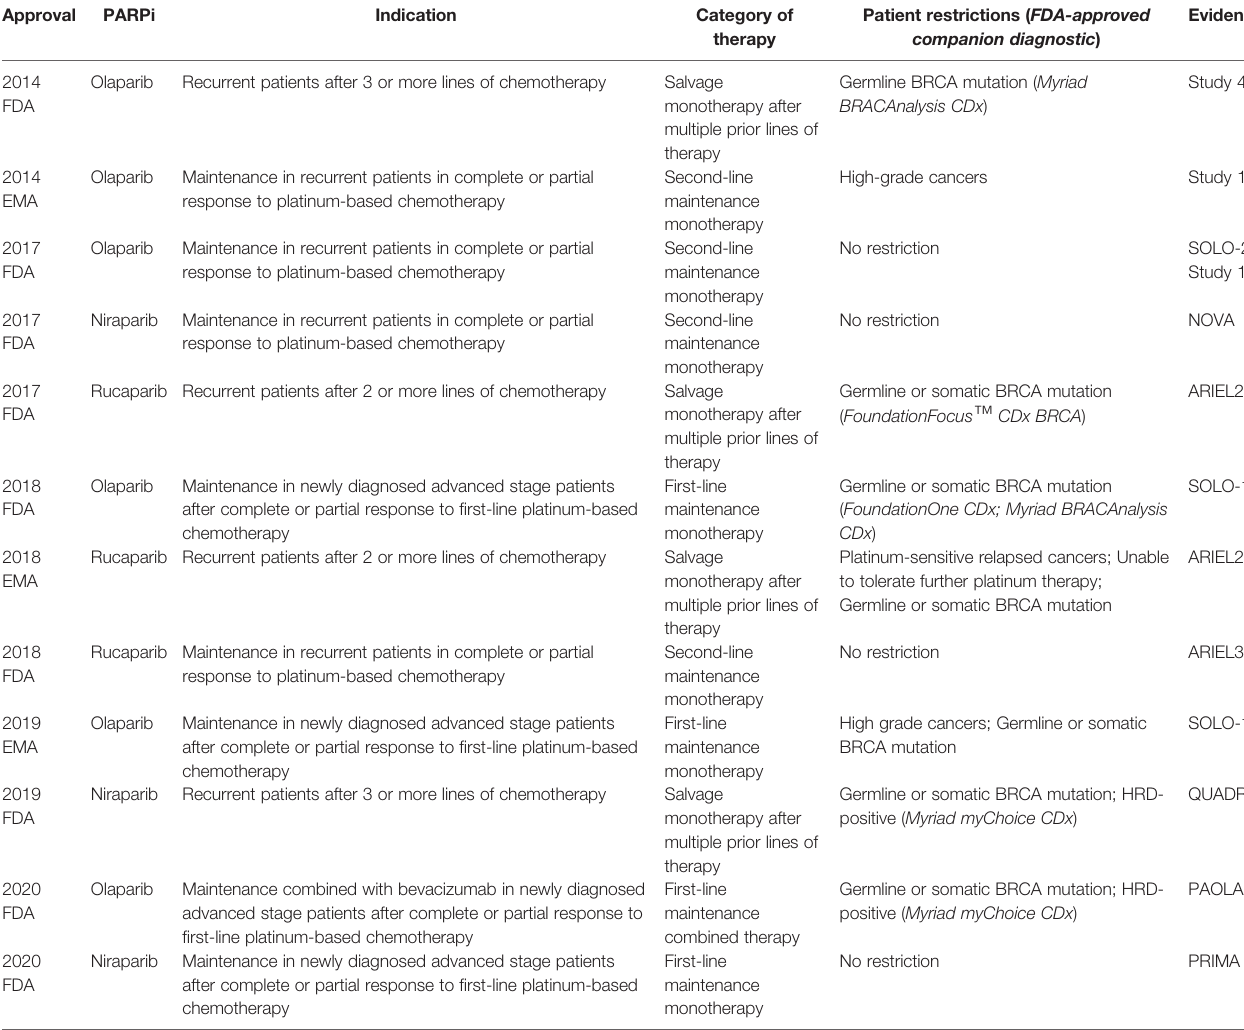
TABLE 3 | FDA and EMA approval of PARP inhibitors in epithelial ovarian